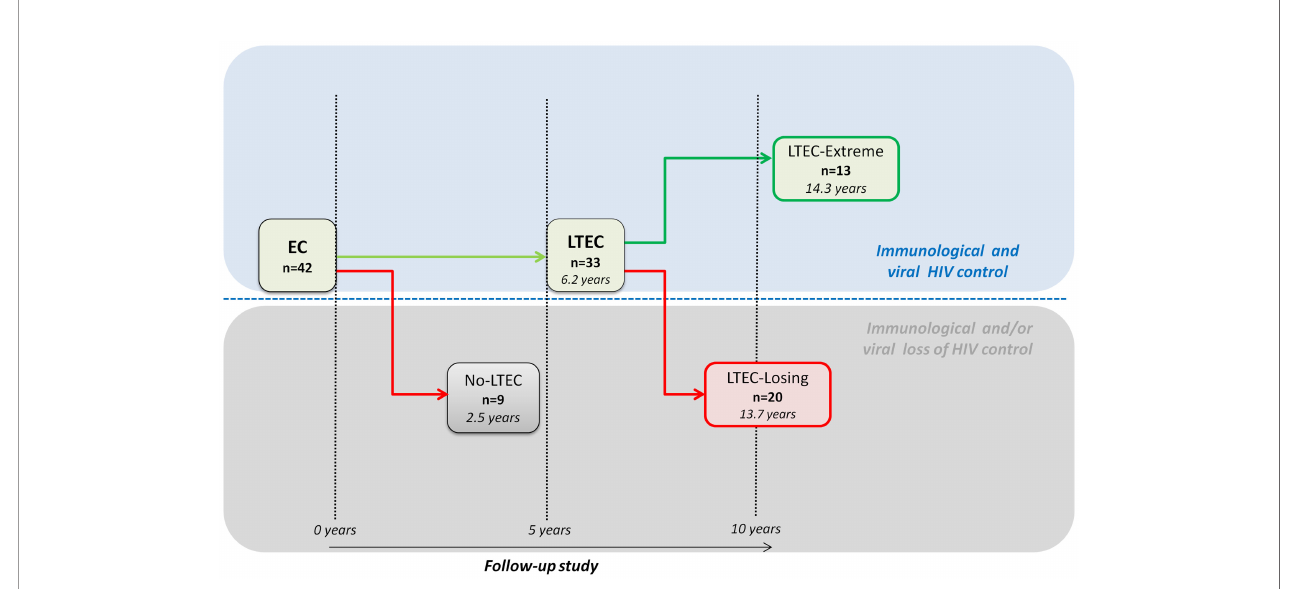
FIGURE 1 | Flowchart illustrating patient cohort enrolment and analysis. From the 42 elite controllers (ECs) analyzed, 9 individuals who experienced a loss of spontaneous viral HIV-1 control in less than 5 years were classi fi ed as no long-term elite controllers (no-LTEC); 33 EC individuals who maintained viral and immunological control for at least 5 years were de fi ned as long-term elite controllers (LTECs). Among the LTEC groups, 13 patients were classi fi ed as LTEC-extreme (de fi ned as LTECs maintaining viral and immunological control throughout the whole follow-up period and for more than 10 years); and 20 were classi fi ed as LTEC- losing (de fi ned as LTECs that lost viral and immunological HIV control during follow-up). Loss of viral control was described as two consecutive measurements of plasma HIV-RNA load above the lower detection limit and a statistically signi fi cant negative slope of CD+ T-cell count during the follow-up